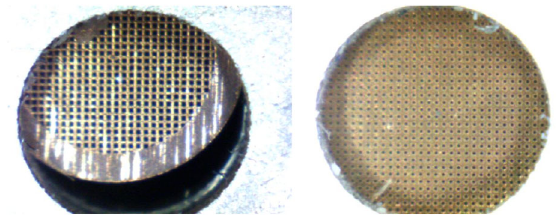
FIG. 9. Photographs of 300-mesh copper TEM grid 1GC300 (left) and pepper pot (right) used for the experiments, taken with a microscope.